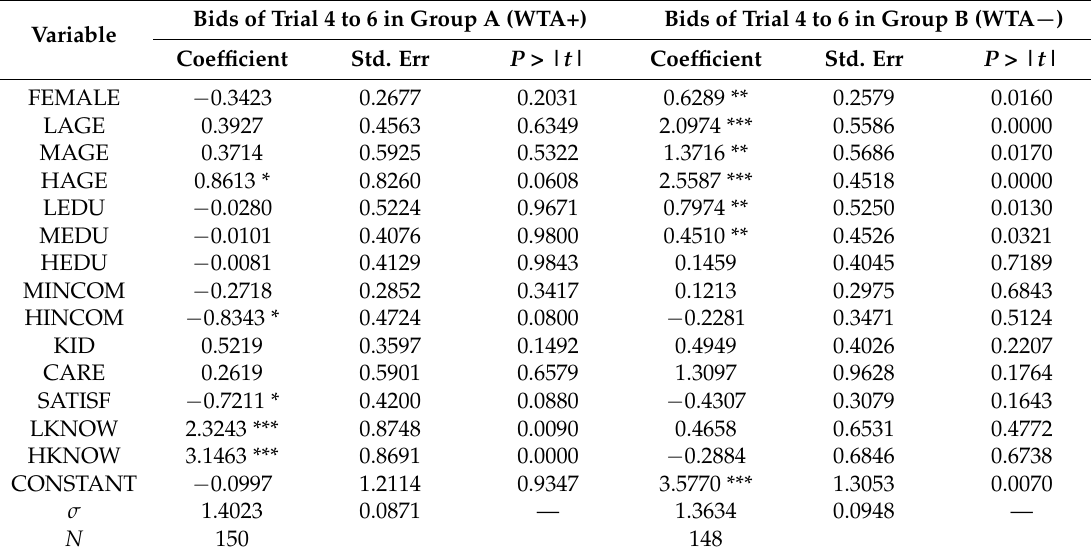
Table 8. Parameter estimation results under single information treatment.